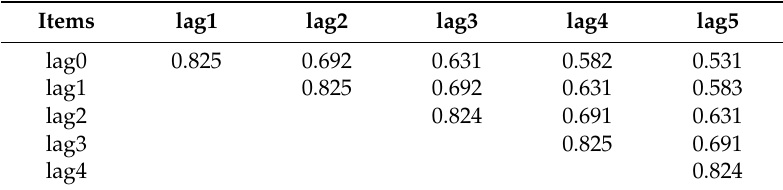
Table 4. Correlation coefficient of different lags for PM 2.5 ( µ g/m 3